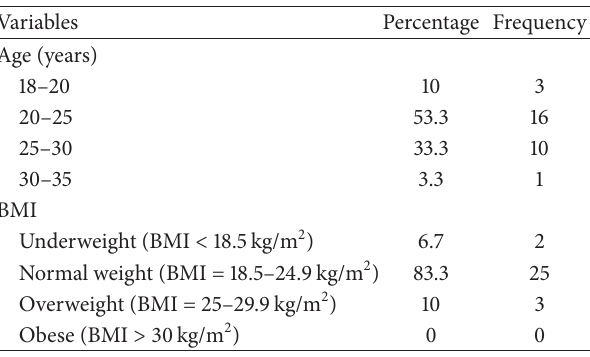
Table 3: Baseline characteristics of participants.